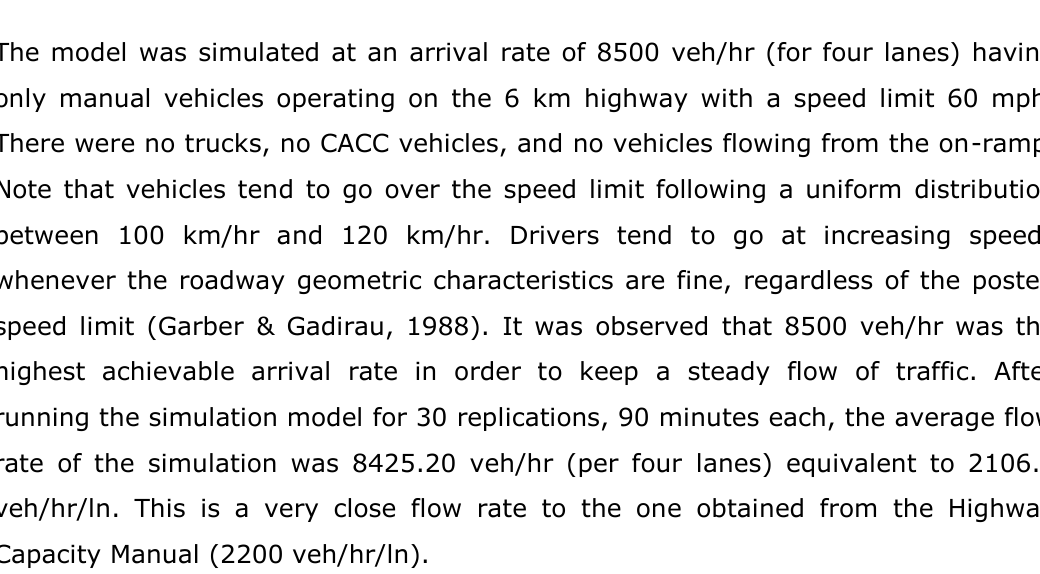
Table 1. Flow Rate according to speed limits (The Highway Capacity Manual, 2000)